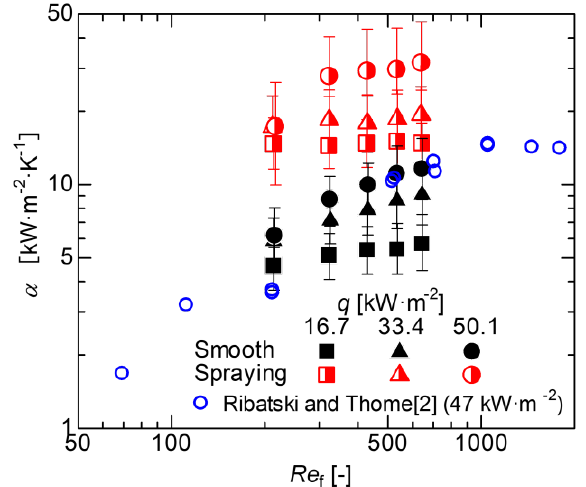
Figure 4. Heat transfer coefficients of falling film evaporation against the film Reynold’s number, Re f .